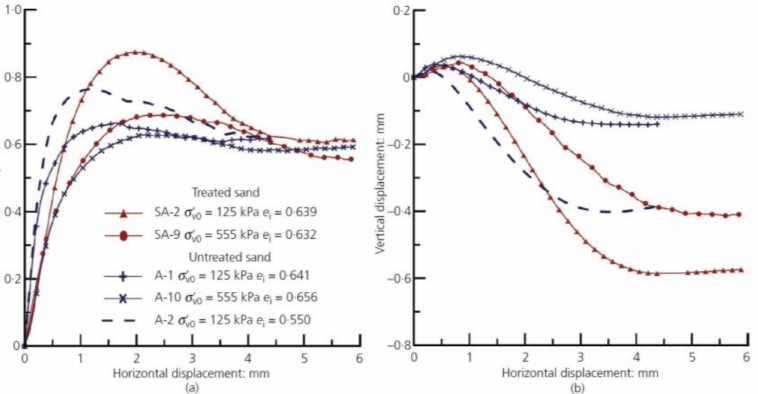
Figure 10. Direct shear stress results for treated and untreated sand: ( a ) stress ratio vs. horizontal displacement; ( b ) vertical vs. horizontal displacement